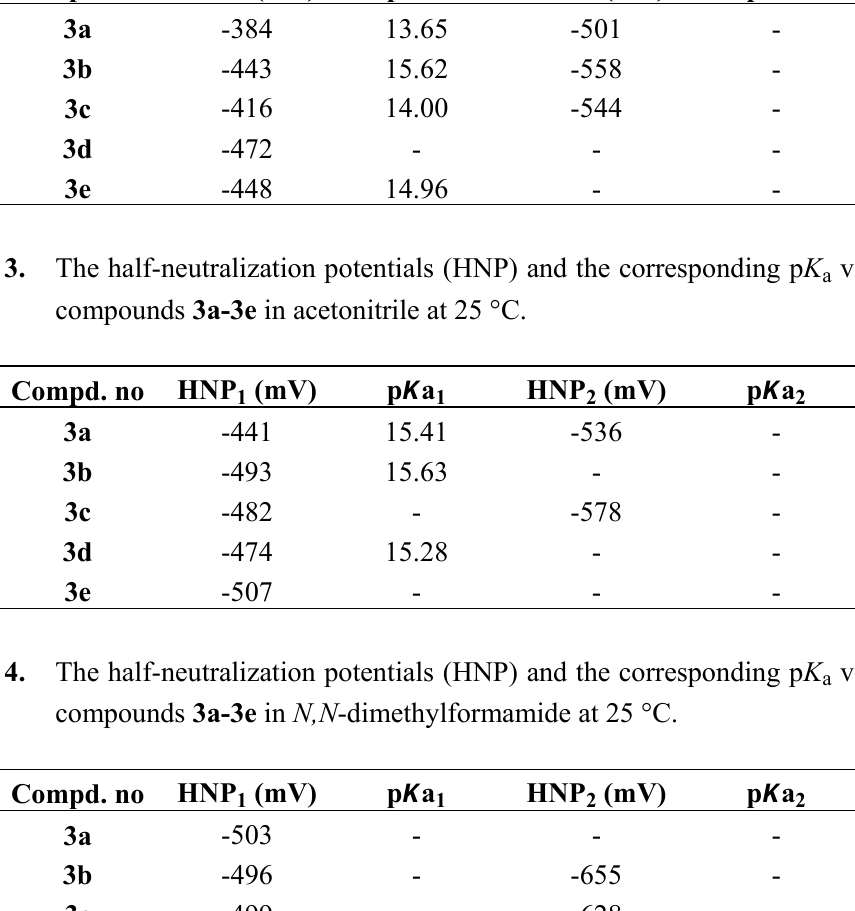
The half-neutralization potentials (HNP) and the corresponding p K compounds 3a-3e in tert -butyl alcohol at 25 °C.